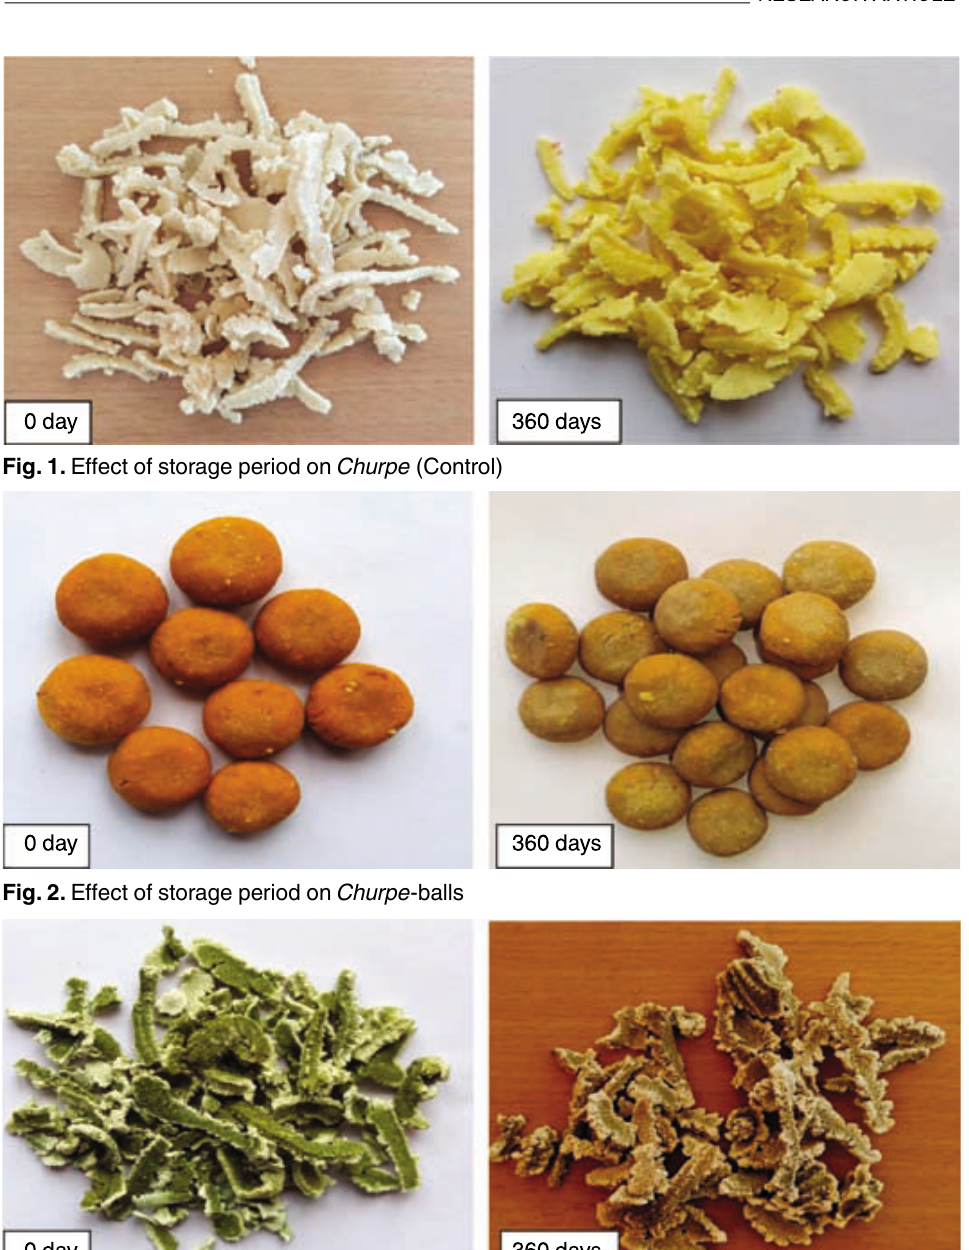
Fig. 3. Effect of storage period on Churpe -strips the levels of the additives as depicted in Table 3. The mean texture score decreased from 6.1 to 5.1 at 5% and 20% apricot incorporations respectively, in case of churpe -balls. This might be due to increase in the hardness of the products because of apricot. Mean texture score also decreased from 7.5 to 6.6 at 3% and 12% spinach incorporations, respectively, in case of churpe -strips. Similar observations were found